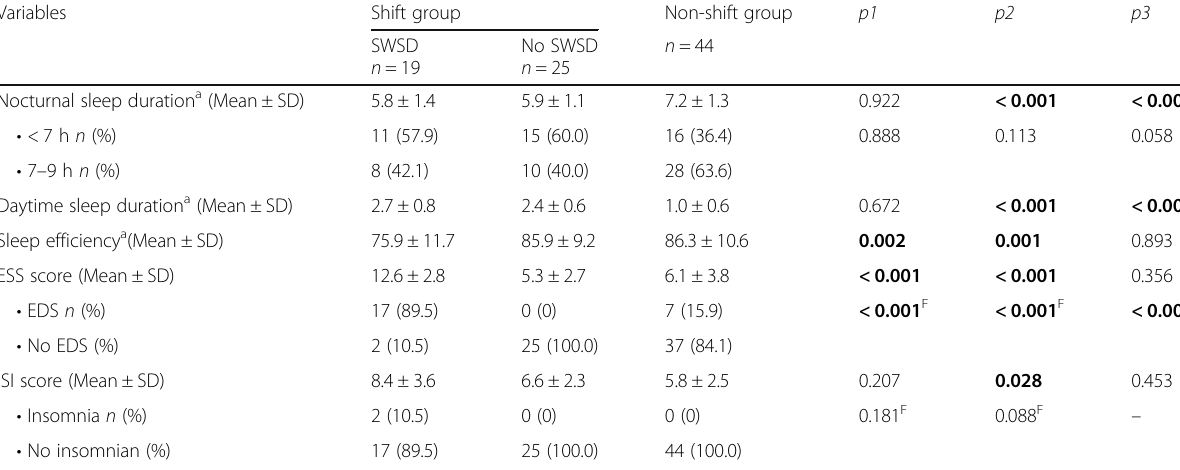
Table 4 Comparison of sleep parameters between SWSD, No SWSD and non-shift Groups Variables Shift group